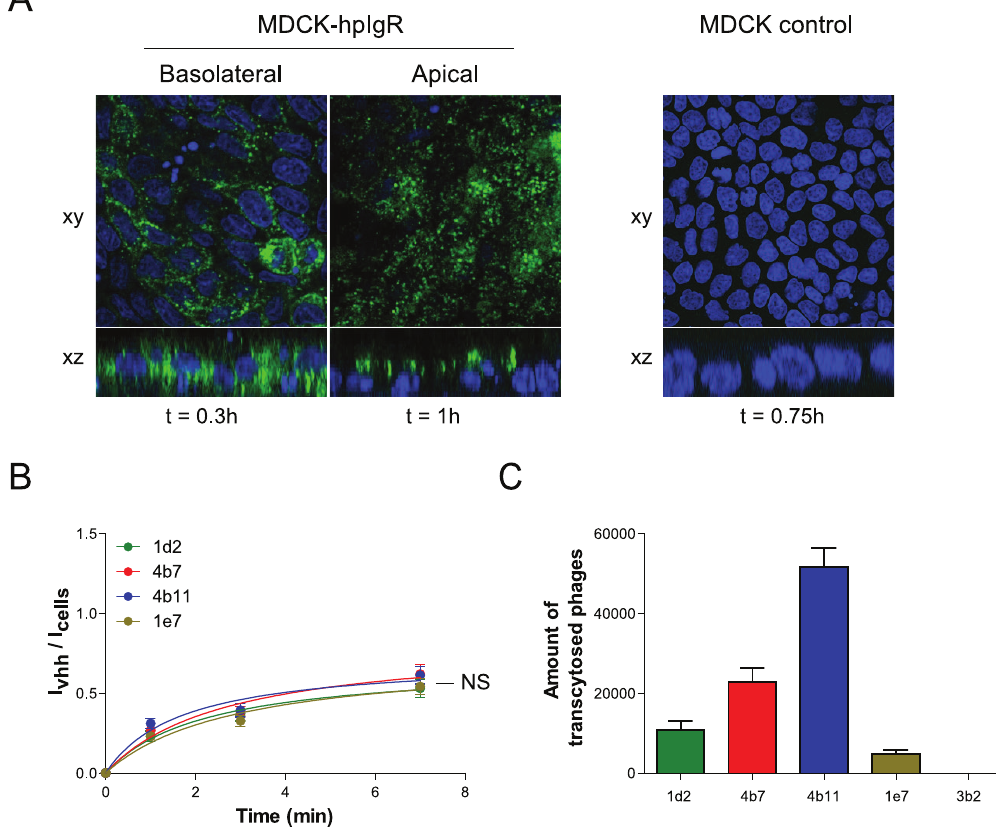
Figure 2. Selected VHHs internalize into and transcytose across polarized epithelial cells expressing hpIgR. (A) 1 m M of 4b7 VHH was applied either basolaterally (for 20 min) or apically (for 60 min) on polarized MDCK-hpIgR cells and visualized after fixation with an anti-myc tag and G- a -M-Alexa488 antibody and DAPI staining both in xy and xz plane (n=4). 1 m M of 4b7 VHH was applied to confluent MDCK control cells and treated as above (n=4). (B) Internalization assay of selected VHHs. 1 m M VHH was incubated on cells at 37 u C for 1, 3 or 7 min. Externally bound VHH was removed with 25 m g/ml trypsin for 45 min on ice. Internalized VHH was immunolabelled with an anti-myc tag and D- a -M-IR800 antibodies. Quantification of fluorescence is described in experimental procedures. Fluorescence intensities of the internalized amount is divided over the amount of cells (To-pro3 nuclear stain) and plotted against time. The signal of the irrelevant anti-hTfR VHH was deducted from the specific VHH signal and therefore represents the x-axis (n=12) (s.e.m.’s are shown for all points). (C) Transcytosis assay using VHH displaying phages. Phages were applied basolaterally and incubated for 5 h. Amount of phages in apical medium is subsequently quantified as described in experimental procedures and plotted per construct (n=4) (s.e.m.’s are shown for all points). Significance measurements were done by two-way ANOVA.